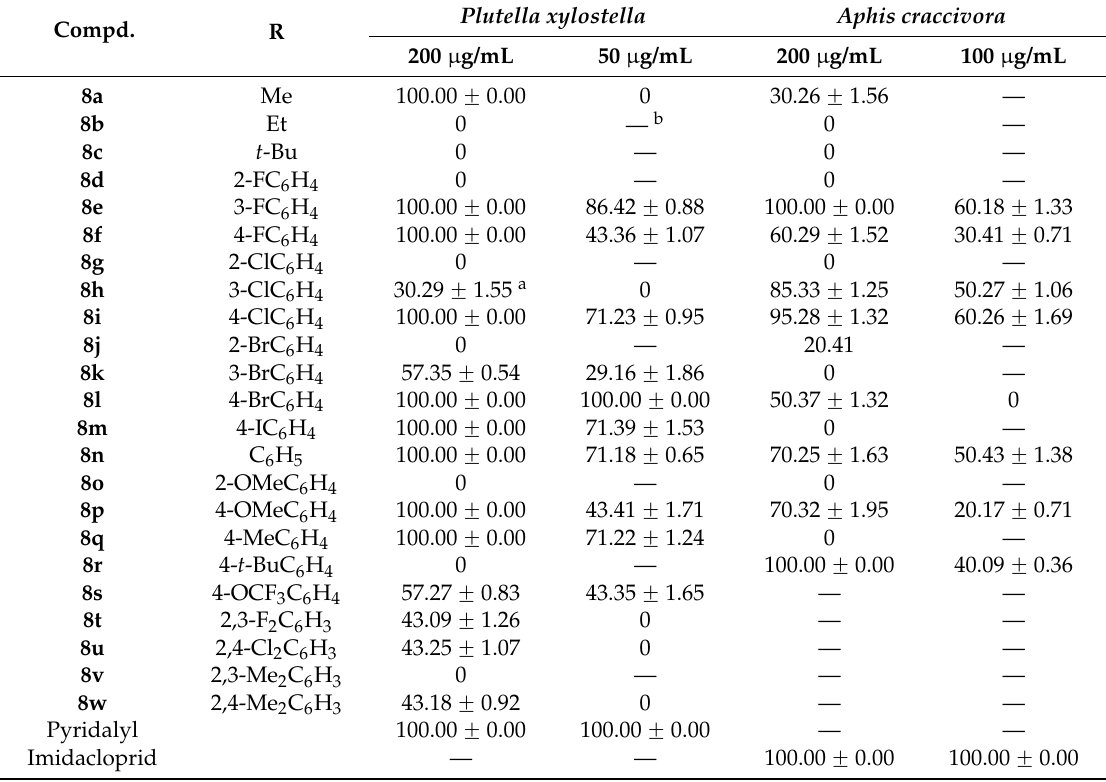
Table 2. Insecticidal activities of compounds 8a – 8w (mortality, %).